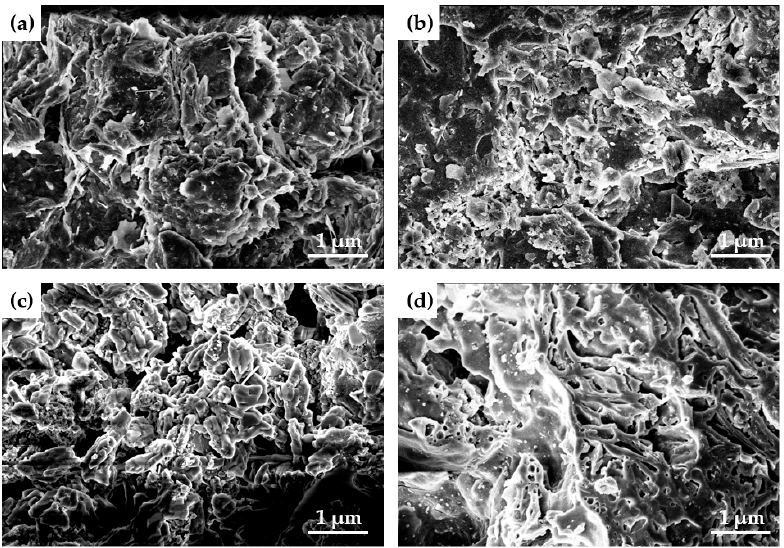
Figure 11. SEM images. ( a ) 30% aluminum dross ( b ) 50% aluminum dross ( c ) 70% aluminum dross ( d ) No aluminum dross.